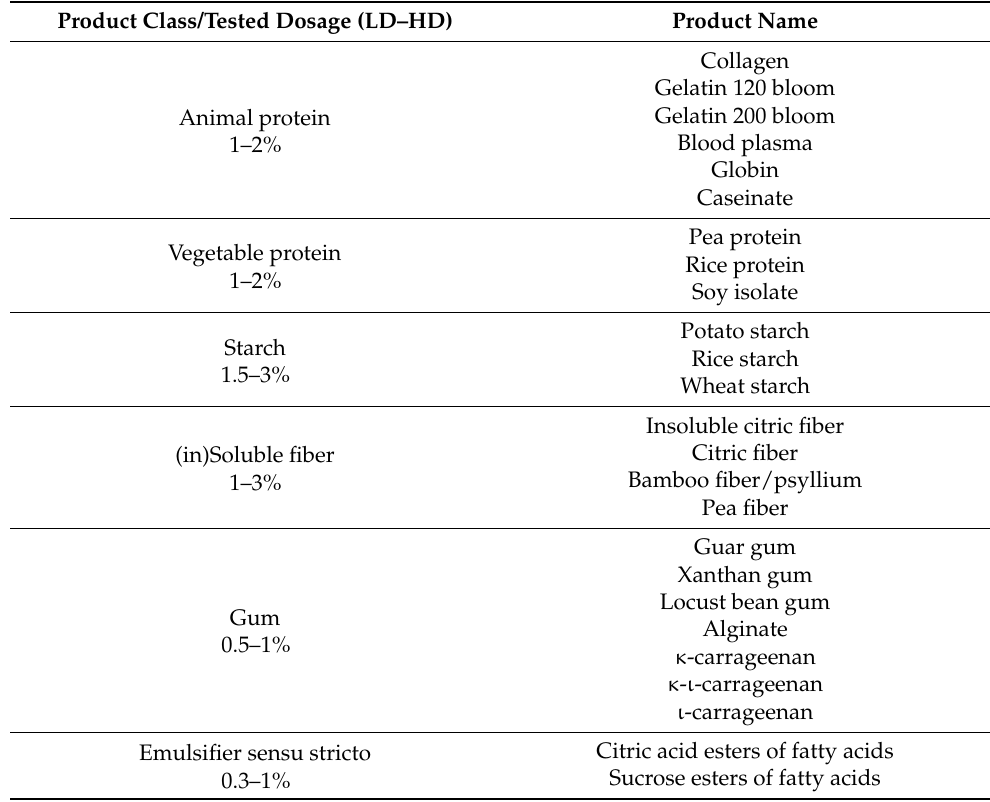
Table 1. Overview of screened ingredients including product names, classes, and tested dosages within each product class (low and high dosage, LD and HD, respectively). Abbreviations used: κ (Kappa), ι